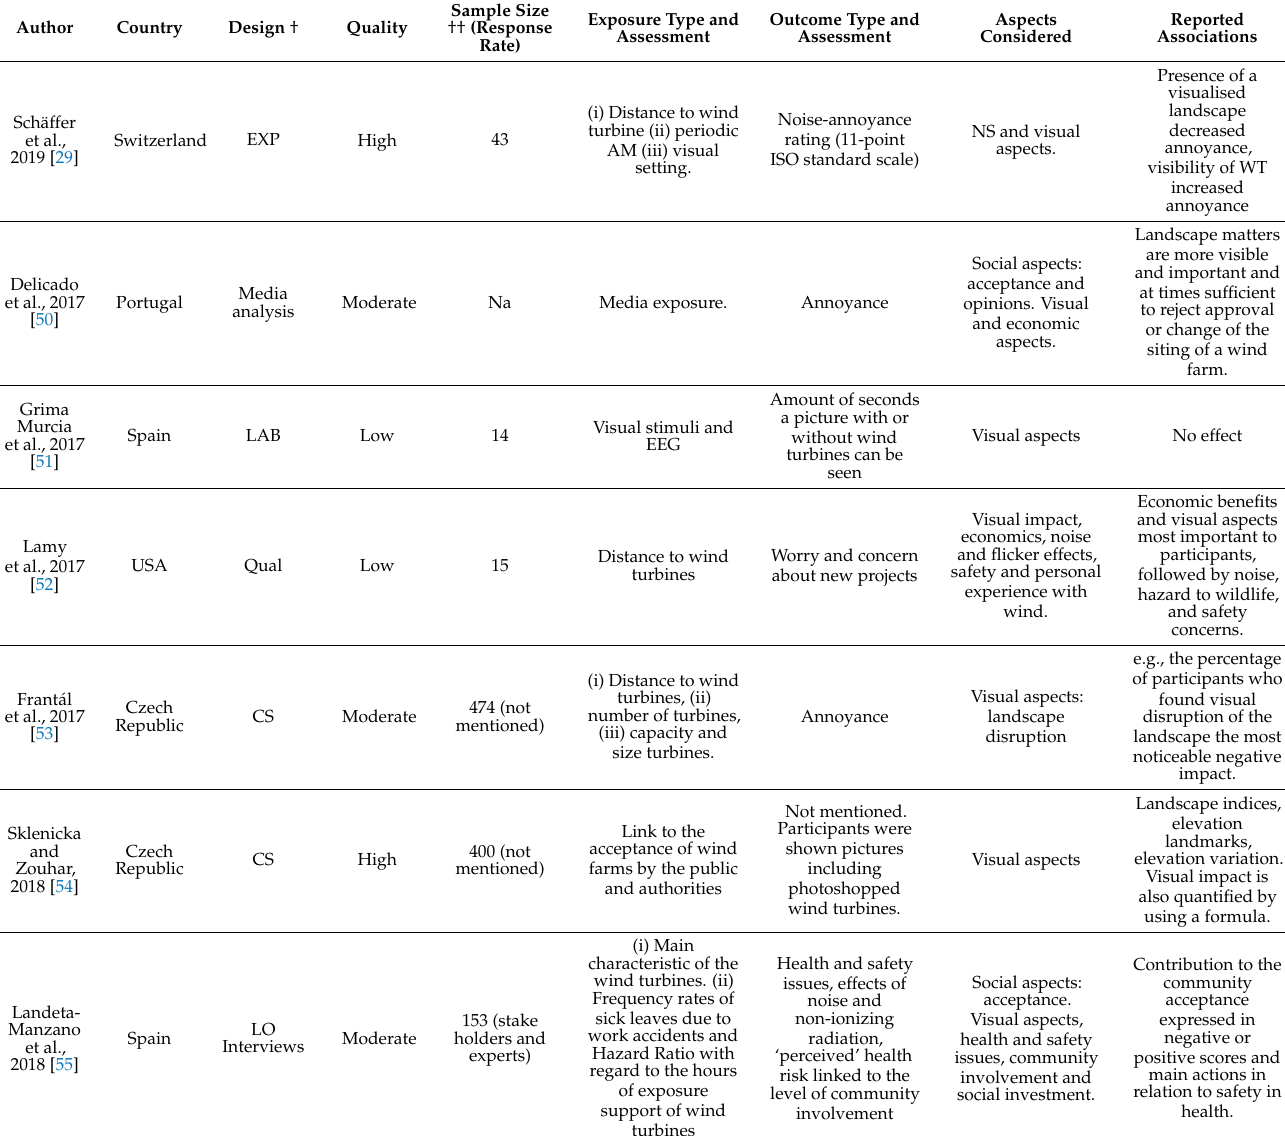
Table 6. Overview of the characteristics of the selected studies on WT sound and visual